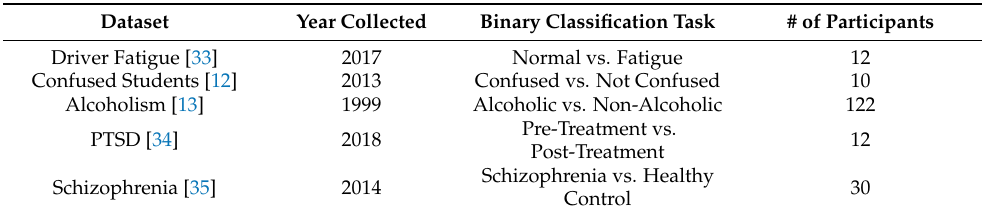
Table 2. Details for the publicly available datasets. All datasets are binary classification tasks, and all datasets are balanced except for the Alcoholism dataset. This gives chance accuracy for Alcoholism defined as 0.64 and 0.50 for all other